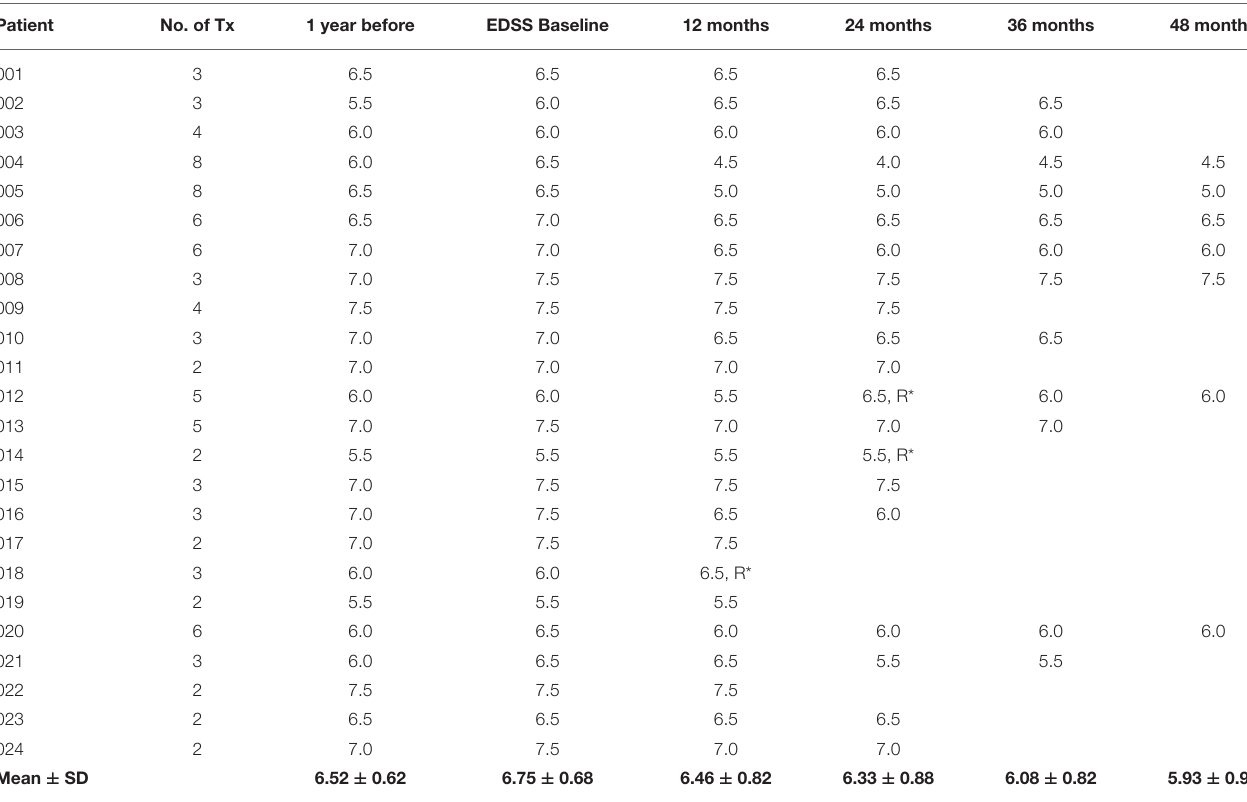
TABLE 3 | Long-term clinical effect of multiple MSC transplantations.